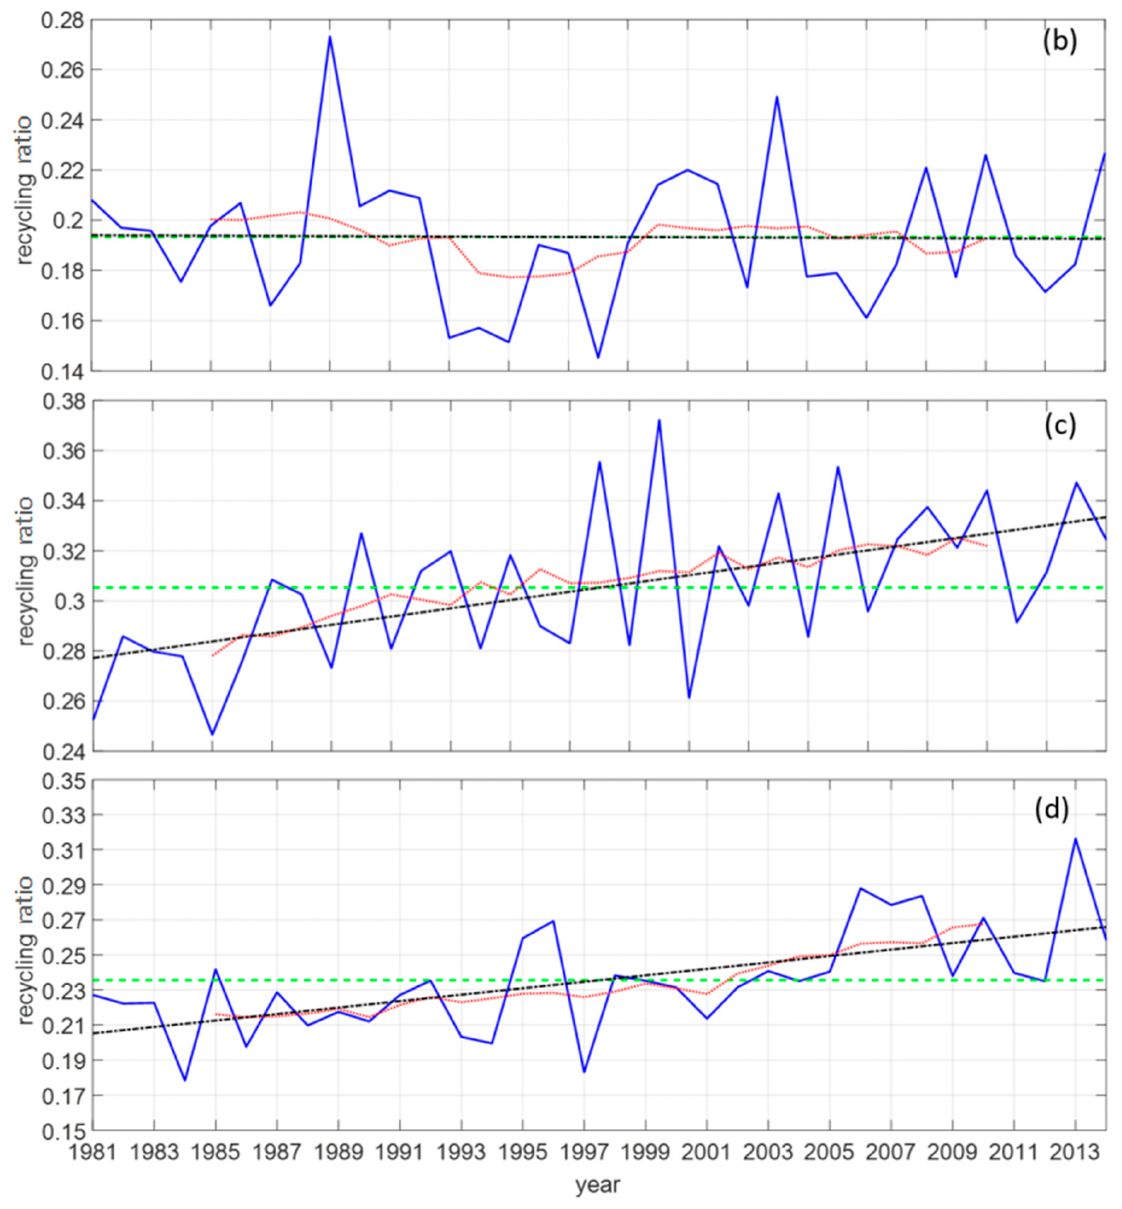
Figure 4. Interannual variability of precipitation recycling ratio in the middle and lower reaches of Yangtze River ( a ) spring ( b ) Summer ( c ) Fall ( d ) Winter (Blue polyline). The green dotted line is the multi-year mean value, the black dotted line is the linear trend, and the red discount is the 9-year sliding mean value.